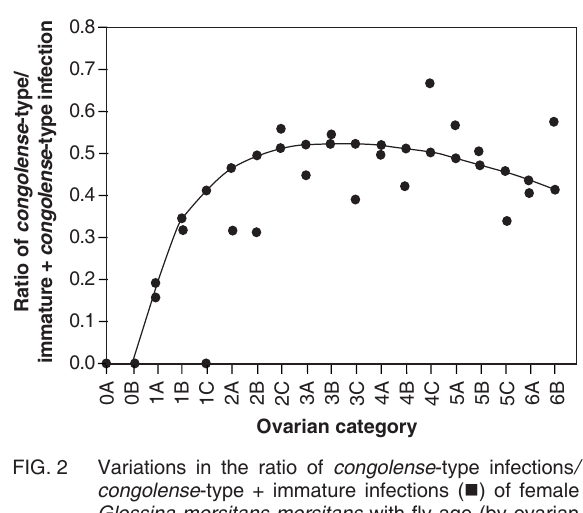
FIG. 2 Variations in the ratio of congolense -type infections / congolense -type + immature infections ( (cid:132) ) of female Glossina morsitans morsitans with fly age (by ovarian